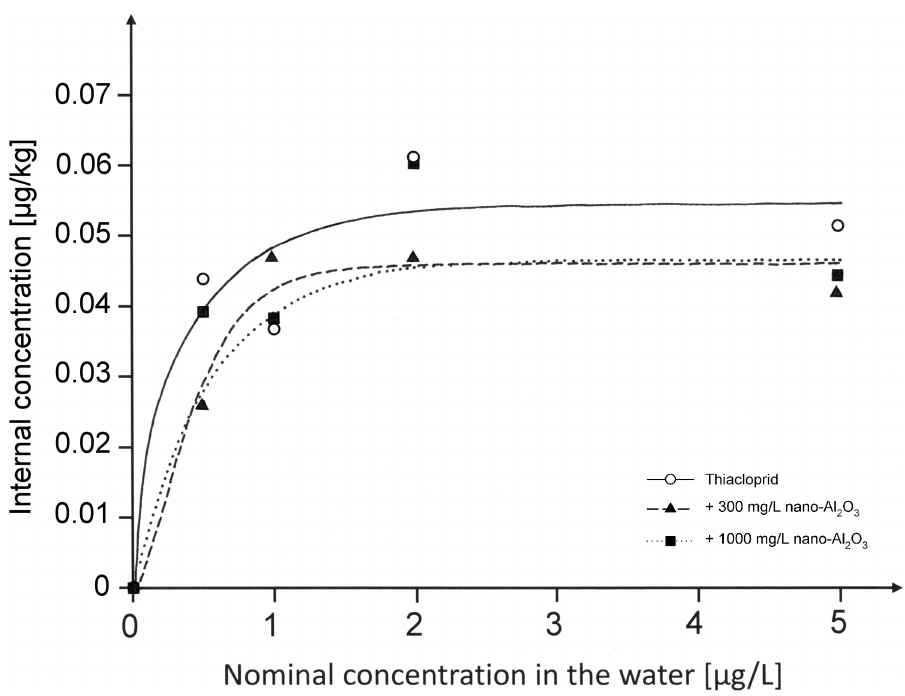
Fig 1. Internal thiacloprid concentrations in C . riparius larvae [ μ g/kg] vs nominal concentration in water [ μ g/L]. Larvaewere exposedfor 96 h before they were transferred to filtered and dechlorinatedtap water for 24 h to empty their guts (n = 1–3). R 2 of the respectiveregression curves were 0.91 for Thiacloprid, 0.97 for animalsexposedto the mixture including 300 mg/L nano-Al 2 O 3 and 0.82 for animalsexposedto a mixturewith 1000mg/L nano-Al 2 O 3 . Nominalvaluesare shownin this graph,whereas measured concentrations canbe obtainedfrom Table1.